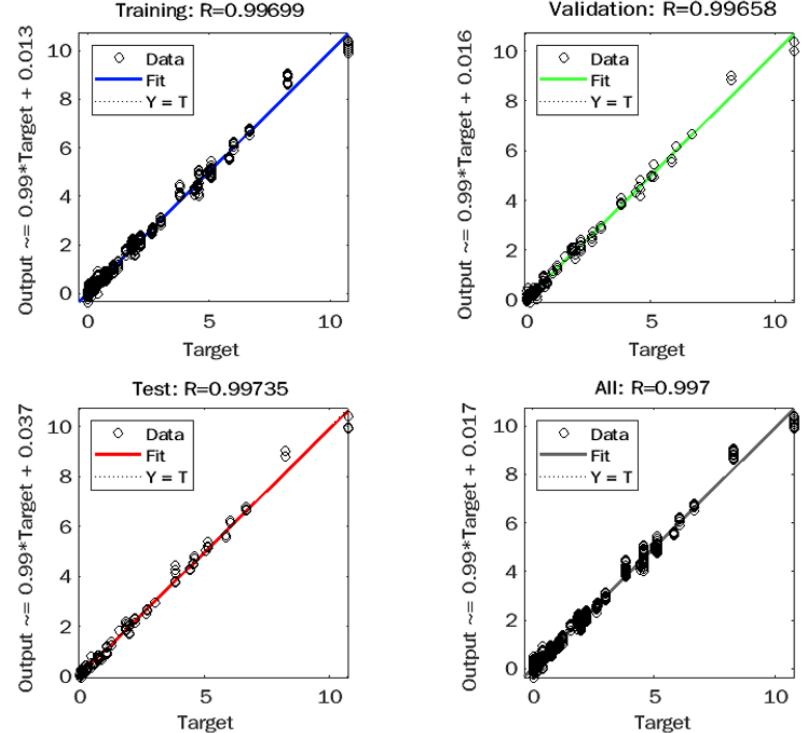
Figure 13. Observed versus predicted plot for J nr 3.2 of RTFO